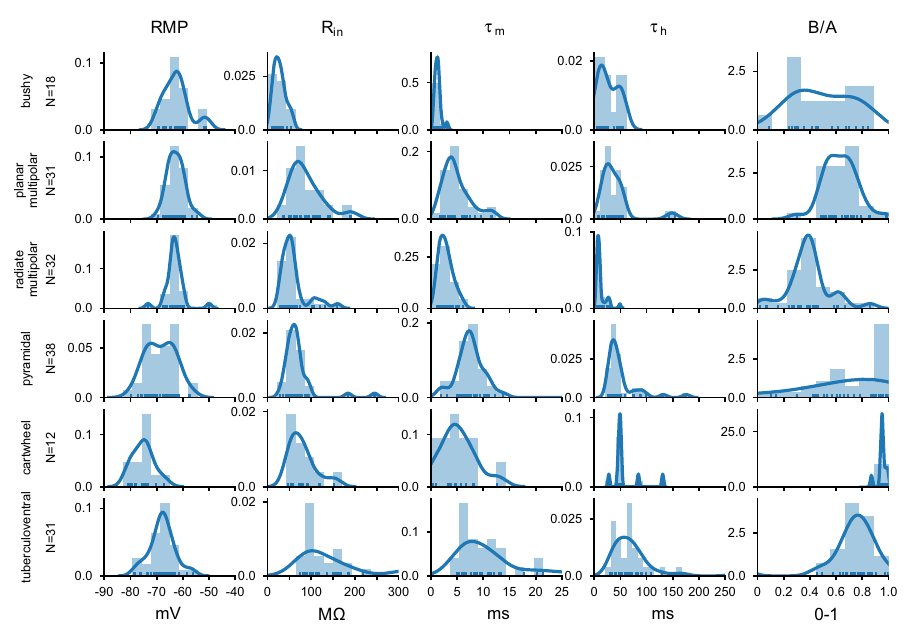
Fig 2. Summary of passive measurements from responses to hyperpolarizing current pulses across the population of CN neurons. RMP: resting membrane potential; R in : input resistance; τ m : membrane time constant; τ h : time constant of repolarizing sag from traces near -80 mV; B/A: steady-state over peak voltage deflection for hyperpolarizing sag (see Materials and Methods and [23]). The ordinate indicates the population density based on the kernel density estimate (blue line). The histograms shows the distribution of values from the population cells for each type and measure.